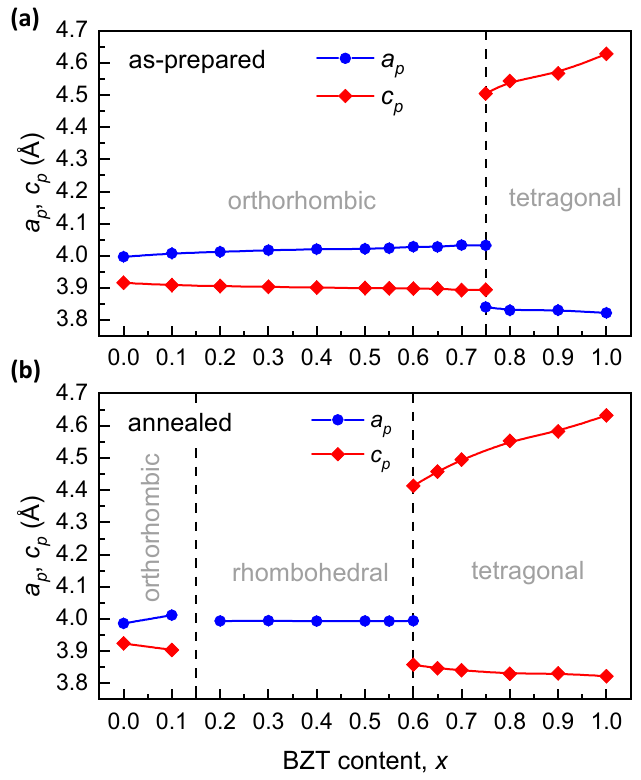
Figure 6. The primitive perovskite cell parameters of the (1- x )BMT– x BZT perovskite phases as a function of the BZT content ( x ) before ( a ) and after ( b ) annealing with the borders of the different phase ranges indicated.